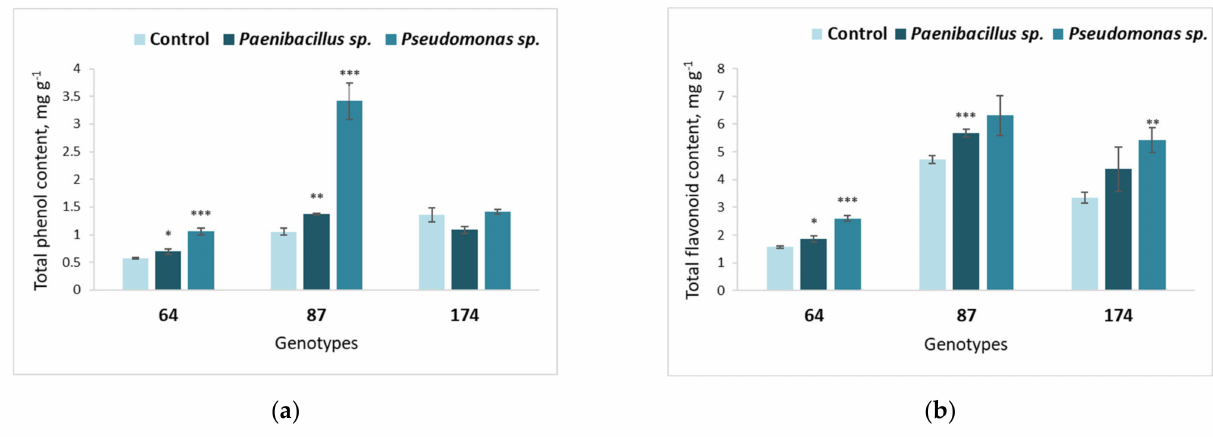
Figure 5. Average TPC ( a ) and TFC ( b ) in the leaves of different F. excelsior genotypes (64, 87 and 174), inoculated with Paenibacillus sp. and Pseudomonas sp. bacteria. Statistically significant differences from the bacterium-free control variant are indicated (for each genotype separately): * p < 0.05; ** p < 0.01; *** p <